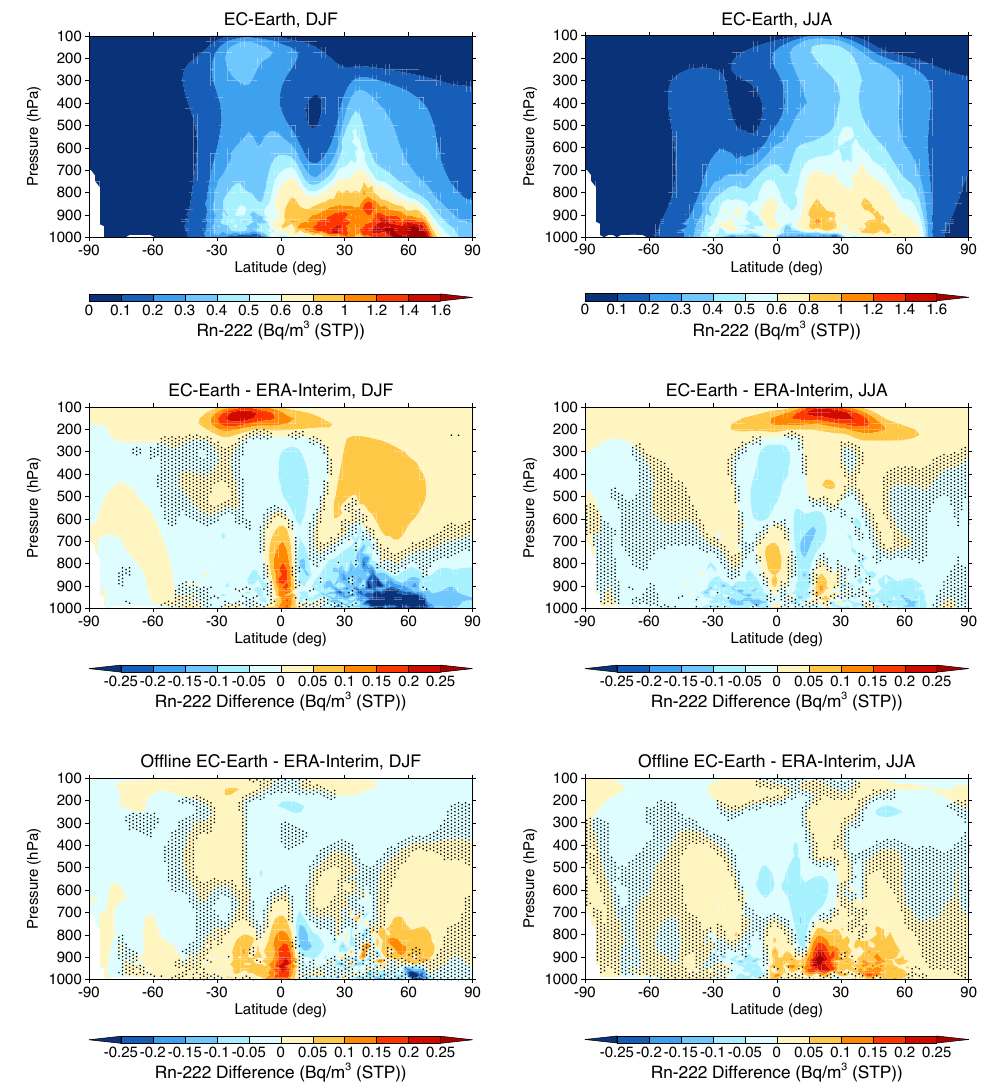
Figure 2. Zonal mean radon-222 concentrations in the online EC-Earth simulation (top) and the differences compared to the ERA-Interim (middle) and offline EC-Earth (bottom) simulations for boreal winter (left) and boreal summer (right).